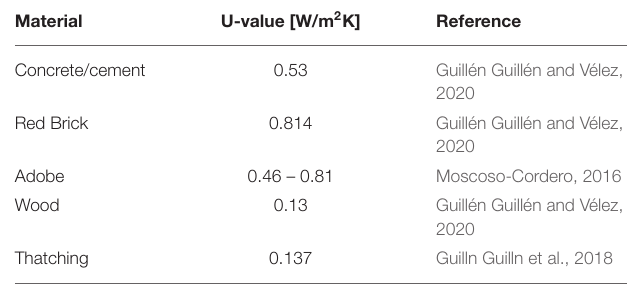
TABLE 2 | Maximum thermal transmittance (U-values) in Mexico (CONAVI, 2017). Element